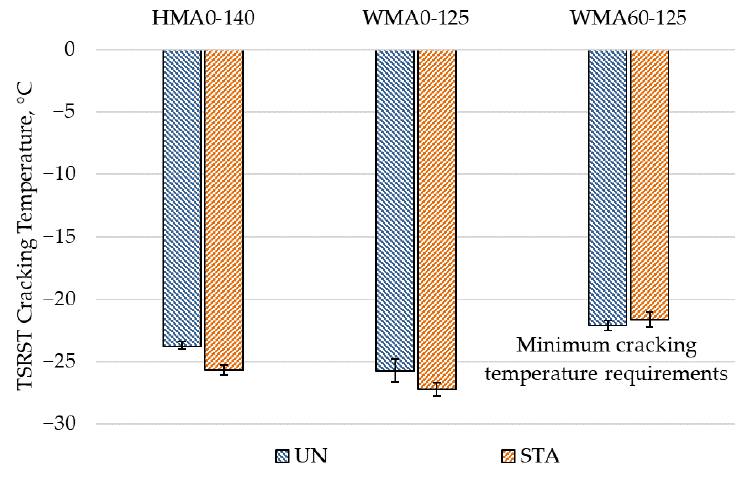
Figure 4. Low-temperature cracking test results.